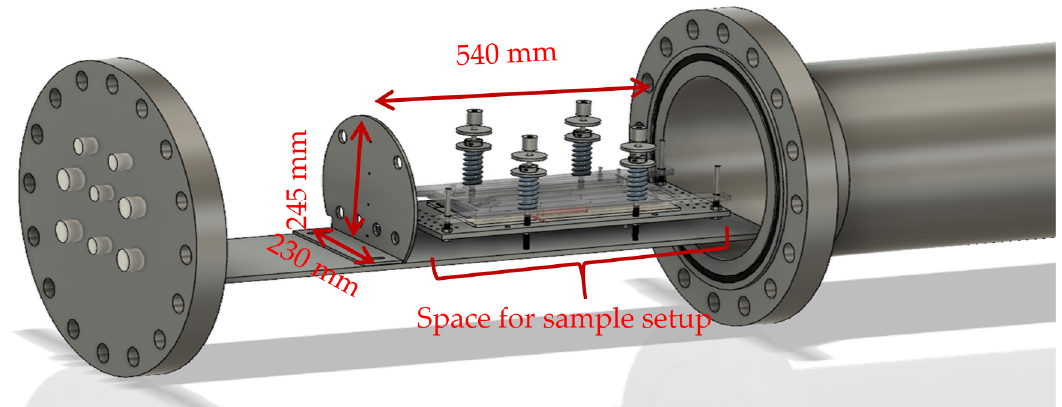
Figure 3. Test rig for thermal runaway experiments on automotive cells [19,50] designed for different cell geometries and different sample holders.